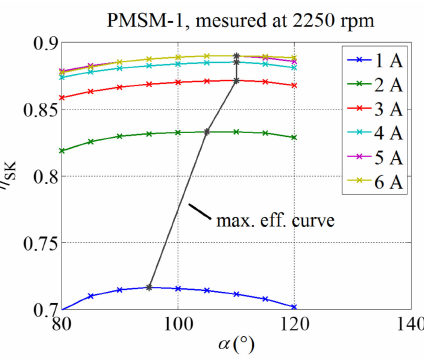
Figure 7. ME characteristic at 2250 rpm in dependence of the length and angle of the stator current vector.